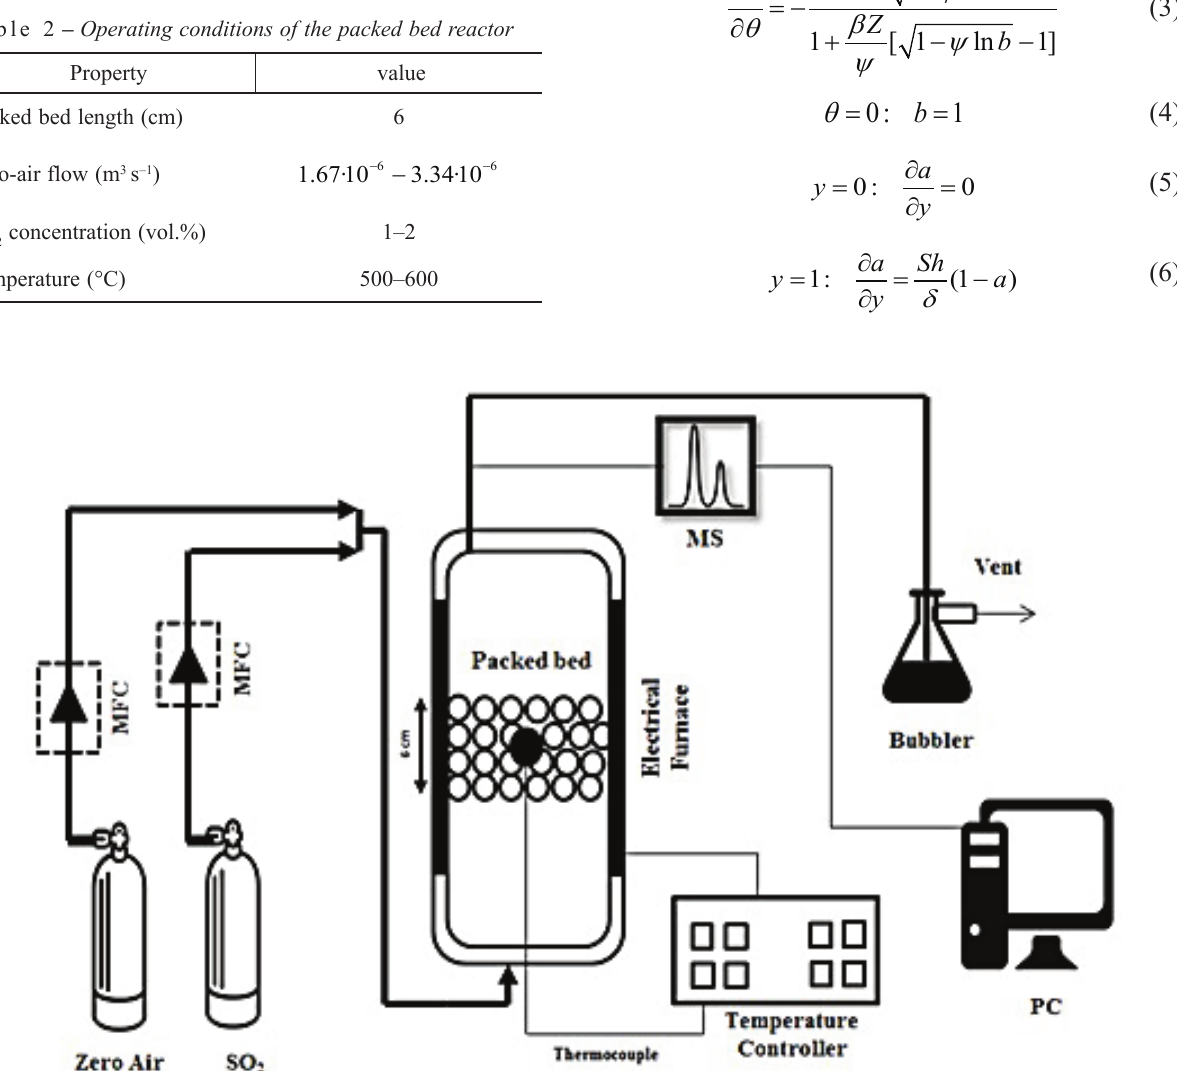
Fig. 1 – Packed bed reactor setup with outlet gas analysis by mass